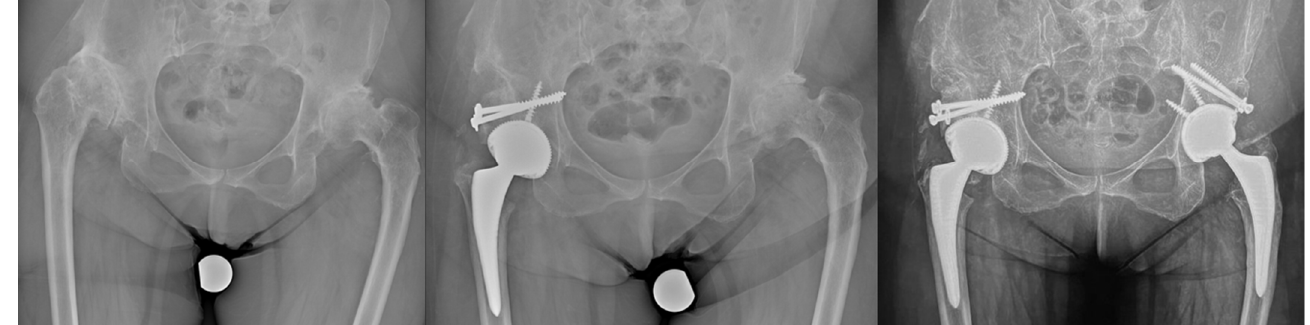
Figure 2. Dysplastic hip patient with bilateral sub dislocation, classified as Crowe III, treated by two stage surgery, restoring the anatomic hip center and repairing the supero-lateral bone defect with femoral head autograft stabilized by 2 screws.